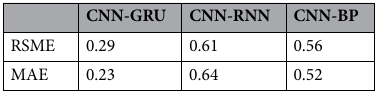
Table 6. Comparison of measurement